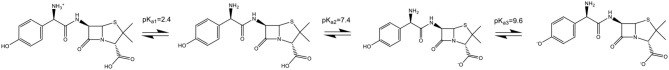
Protonated and deprotonated forms of amoxicillin.